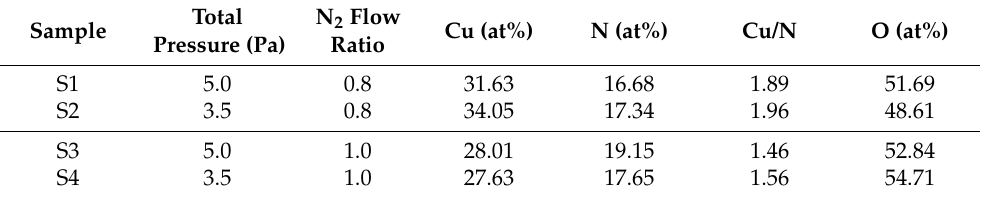
Table 4. Relative surface composition of the films under study, derived from the XPS analysis.